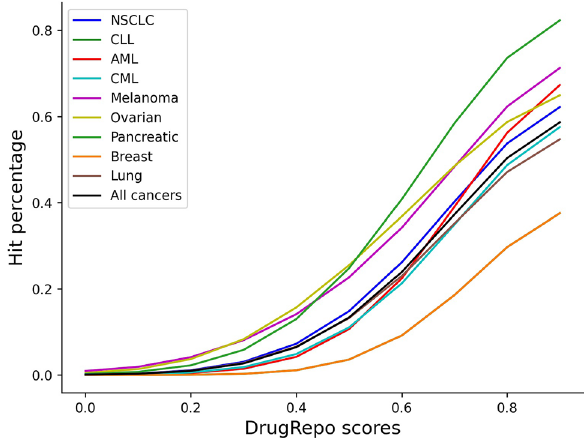
Figure 7. Hit ratio at different thresholds on different DrugRepo scores.The X-axis shows thresholds on DrugRepo scores, and Y-axis shows the percentage of hits while matching with repurposed compounds at https:// clini caltr ials.